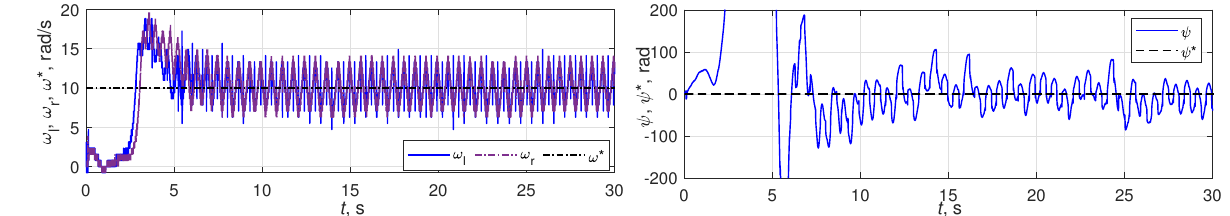
Figure 13. Experiment. Left plot : ω l ( t ) , ω r ( t ) , ω ∗ ( t ) ; right plot : ψ ( t ) , ψ ∗ ( t ) time histories for ω ∗ = 10 rad/s, ψ ∗ =